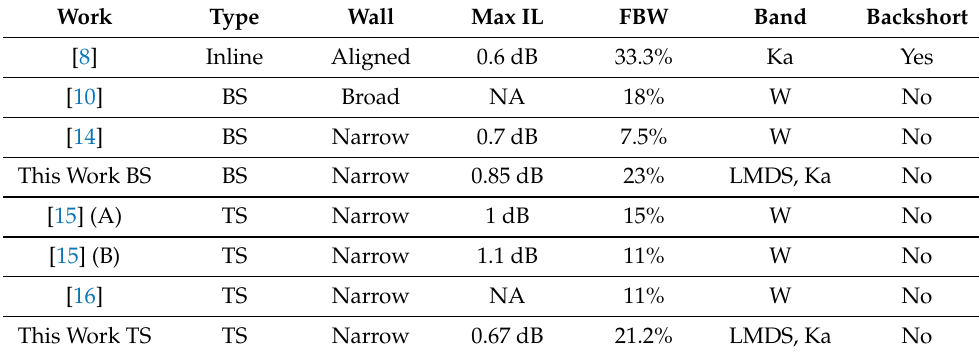
Table 3. Similar work that can be found showing the comparison of B2B parameters like minimum IL, maximum IL, FBW, and the operating